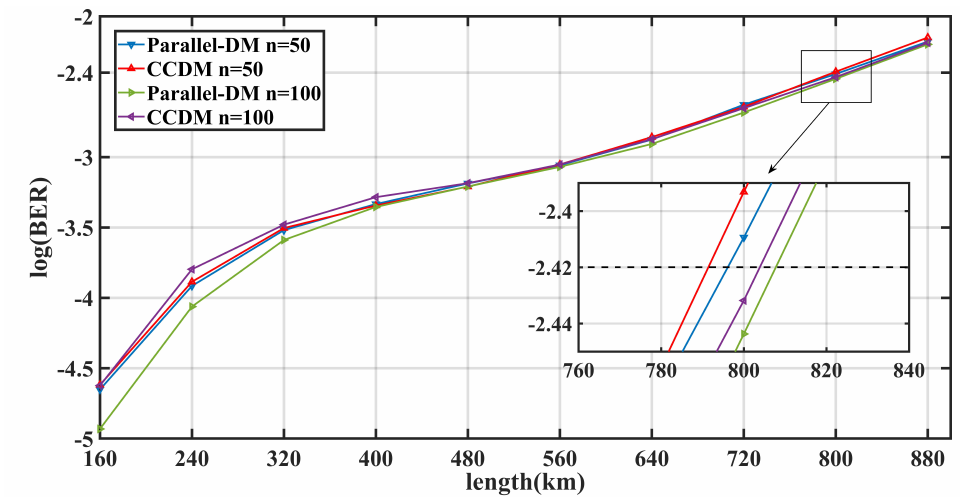
Figure 8. The BER performance over transmission distance in the standard single-mode fiber trans- mission link. The transmission distance of PS-64QAM signals using the parallel distribution matcher is slightly larger than that of PS-64QAM signals using